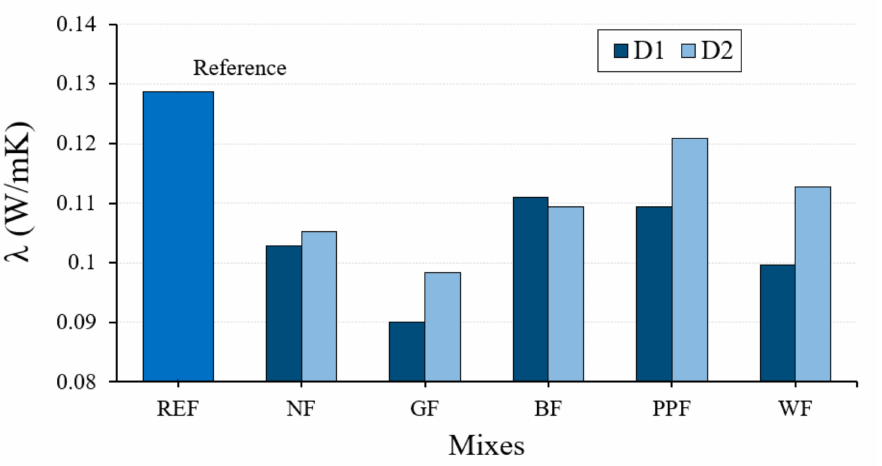
Figure 10. Results of the thermal conductivity obtained for the different dosages